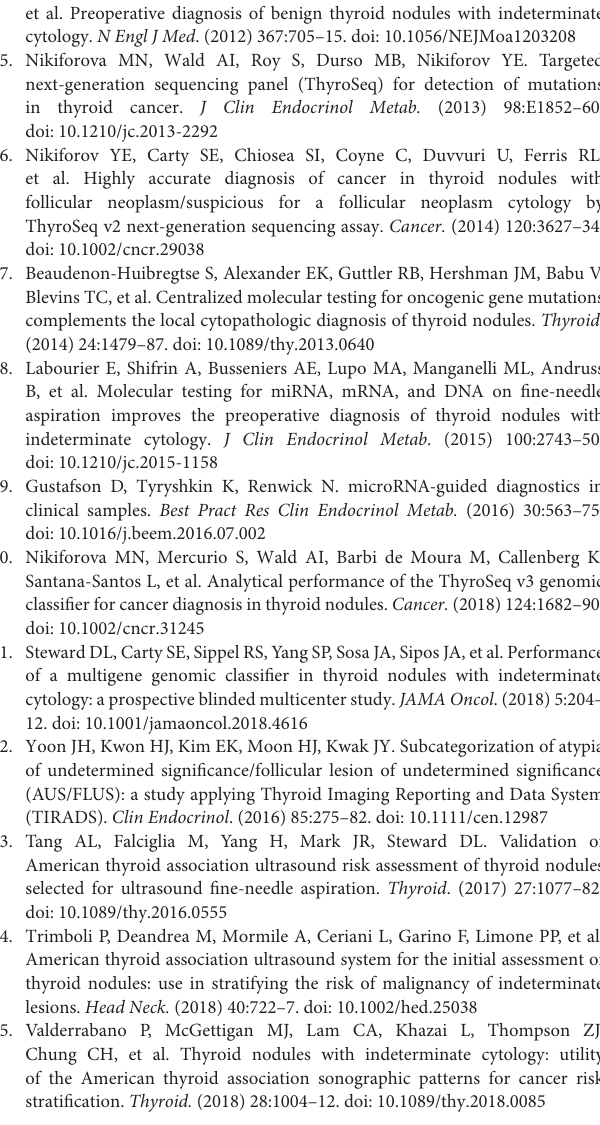
Supplemental Figure 4 | Sub-analysis of the cohort excluding patients with medullary thyroid cancer (MTC)—Predicted performance of each score in populations with different cancer prevalence. Negative predictive value (NPV) in red and positive predictive value (PPV) in blue. (A) Ultrasound score (X US ); (B) genomic classifier score (X GC ); and (C) total risk score (TRS). Supplemental Figure 5 | Sub-analysis of the cohort excluding patients with medullary thyroid cancer (MTC)—Comparison of ROC curves-diagnostic accuracy of X US , X GC, and TRS. Supplemental Figure 6 | Sub-analysis of the cohort excluding patients with medullary thyroid cancer (MTC)— (A) Comparison of diagnostic accuracy of different cut-off points of X US ; (B) comparison of diagnostic accuracy of different cut-off points of X GC ; and (C) comparison of diagnostic accuracy of different cut-off pointsof